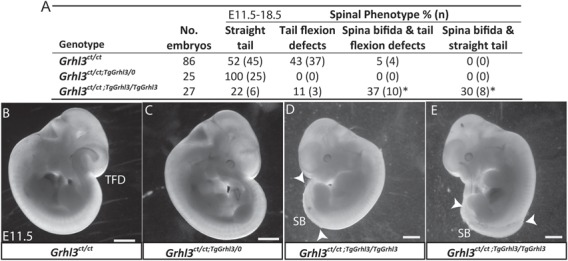
Spinal NTDs in Grhl3-transgenic mice. (A) Occurrence of SB among offspring of matings between Grhl3ct/ct;TgGrhl3/0 (BAC-hemizygous) and Grhl3ct/ct mice analysed at E11.5–18.5 (*, significant difference from other genotypes; P < 0.001, Chi-square). (B–E) Embryos of the three genotypes at E11.5. All Grhl3ct/ct;TgGrhl3/0 embryos appeared normal with a straight caudal region (C), whereas a proportion of Grhl3ct/ct (B) and Grhl3ct/ct;TgGrhl3/TgGrhl3 (D, E) exhibited TFDs and/or SB (extent of open region indicated by arrowheads). Scale bar represents 1 mm.